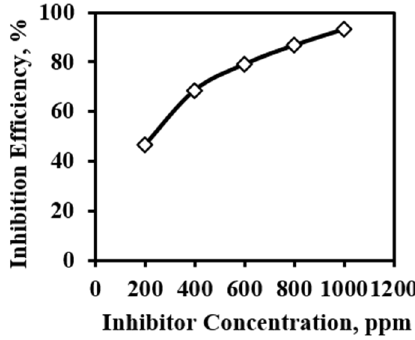
Figure 10. Inhibition efficiency of inhibitor obtained from the polarization of 3 h immersed MS sample in 1 M H 2 SO 4 in presence of inhibitor.